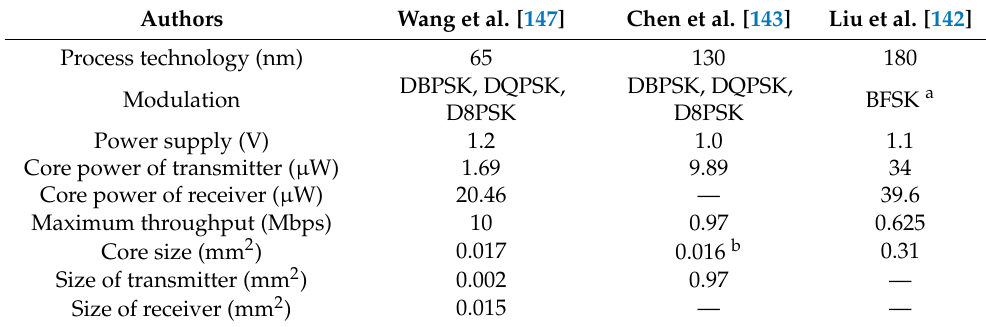
Table 13. Performance comparison of the existing ASIC design methods. Authors Wang et al. [147] Chen et al. [143] Liu et al. [142] Process technology (nm)